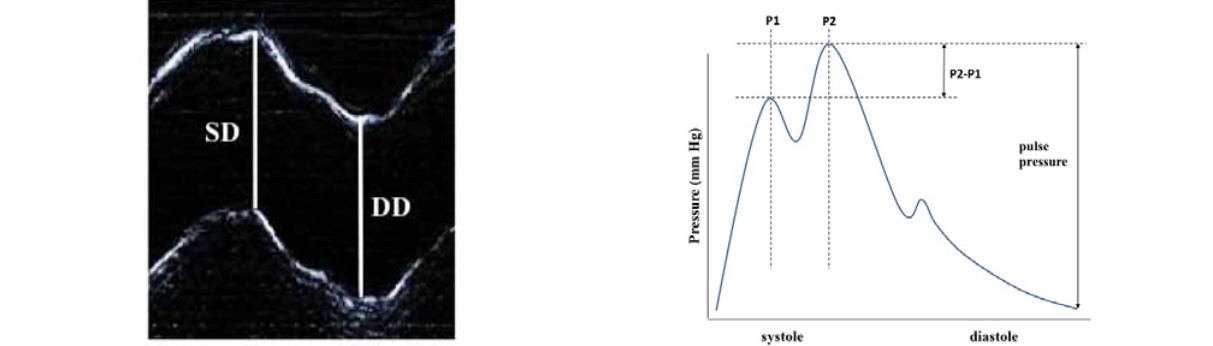
Figure 2. An Arteriography-derived oscillometric pulse wave is presented, where P1 is the pressure peak of the initial wave in mm Hg and P2 is the pressure pressure peak of the reflected wave in mm